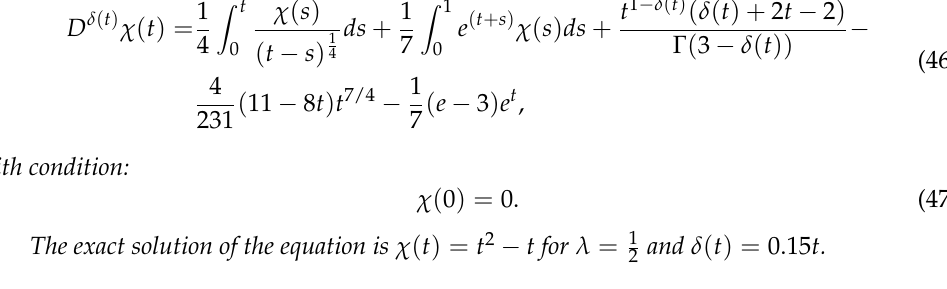
) , ( σ , ρ ) = ( 0,0 ) and λ = 1 2